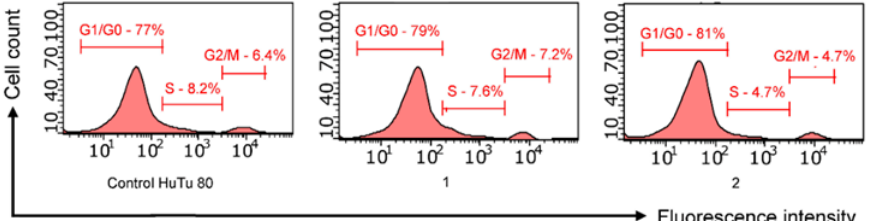
Figure 1. Effect of compound 2а on cell cycle of HuTu 80 by flow cytometry. 1 – 2а at IC 50 /2 concen- tration (12.5 µM); 2 – 2а at IC 50 concentration (25 µM).